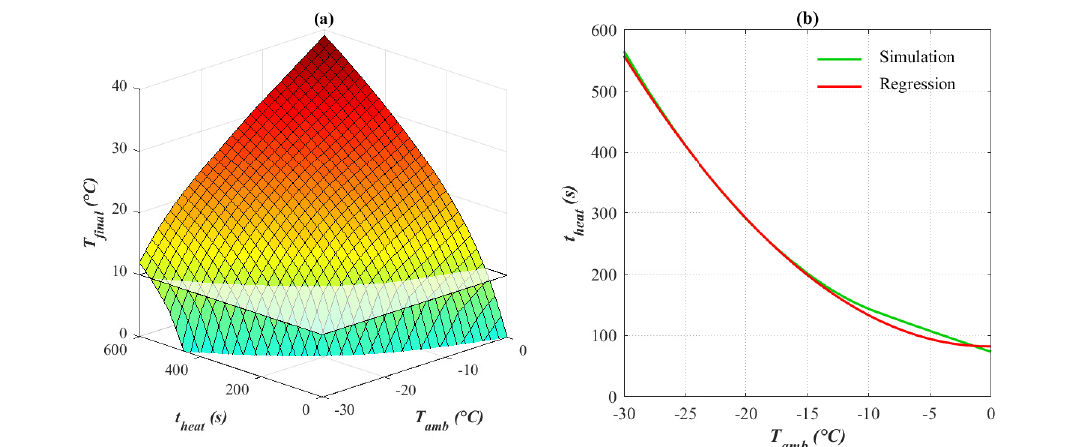
Figure 10. ( a ) Dependencies of the final temperature of the battery pack ( T final ) on heating time and ambient temperature. ( b ) Relationships between heating time and ambient temperature to get T final = 10 ◦